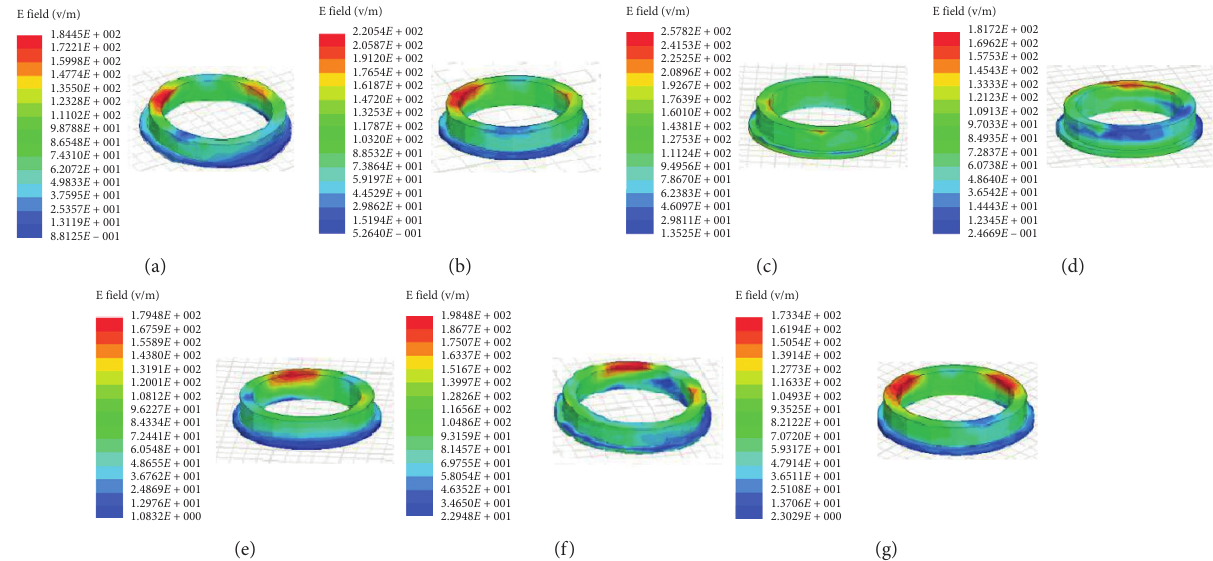
Figure 6: Electric field distribution in ceramic steel ring at different heights ( z -coordinate values). (a) 8.3 cm. (b) 8.6 cm. (c) 8.9 cm. (d) 9.2 cm. (e) 9.5 cm. (f) 9.8 cm. (g) 10.1 cm.